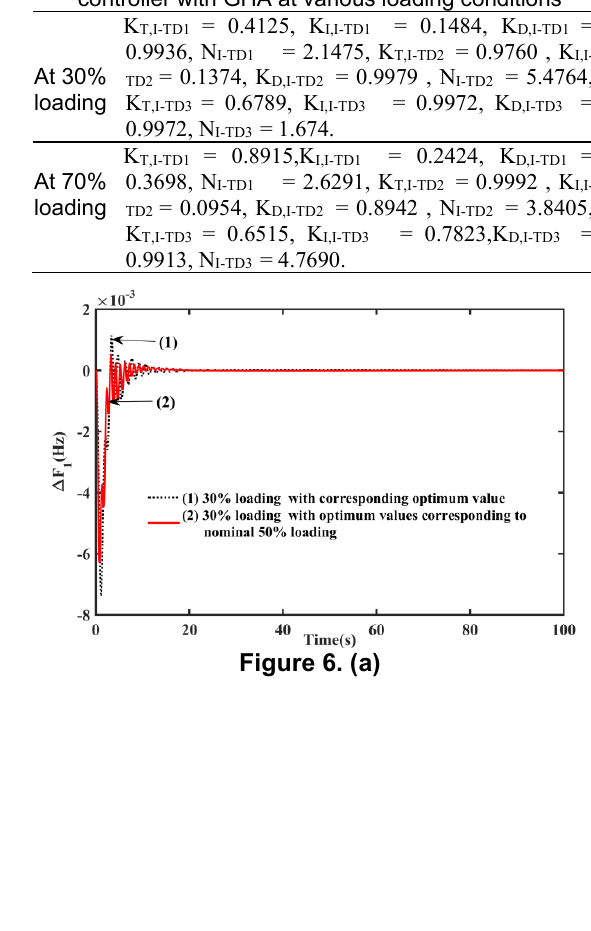
Table 3. Optimum gains and parameter of